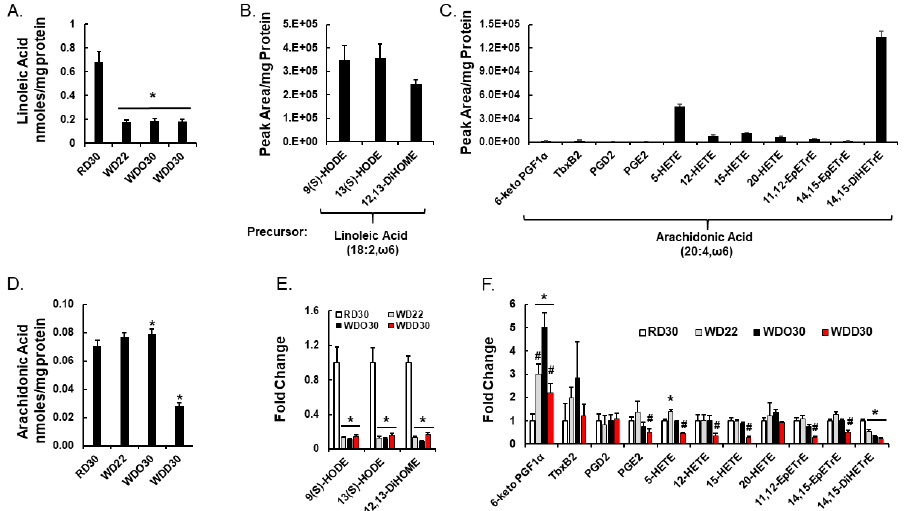
Figure 5. Diet e ff ects on oxylipins derived from ω 6 polyunsaturated fatty acids (PUFA). ( A , D ): Hepatic content of linoleic acid (LA; 18:2, ω 6) and arachidonic acid (ARA; 20:4, ω 6) as determined by gas chromatographic (GC) analysis. Results are presented as nmoles / mg protein, mean ± SEM. Oxylipins derived from LA ( B ) and ARA ( C ) were quantified, by HPLC-dMRM as described in the Materials and Methods Section. Liver samples were derived from the RD group and oxylipin levels are presented as the peak area / mg protein, mean ± SEM. E ff ects of diet on specific oxylipins are presented in (Panels E,F) as Fold Change, mean ± SEM. (Panels E , F ) present LA- and ARA-derived oxylipins,